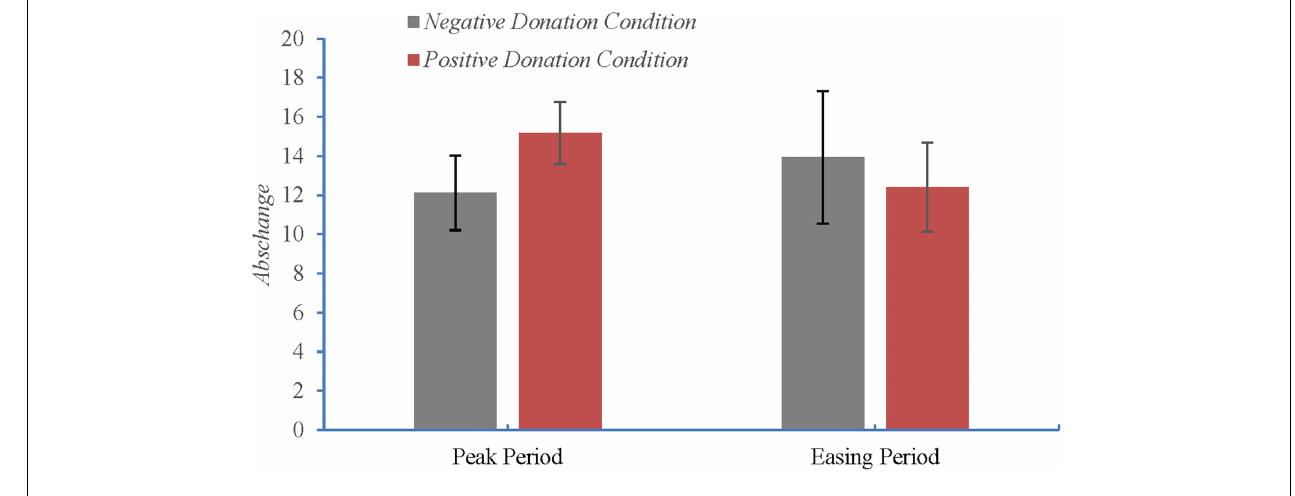
FIGURE 2 | Amount of change in the participants’ donation decisions.